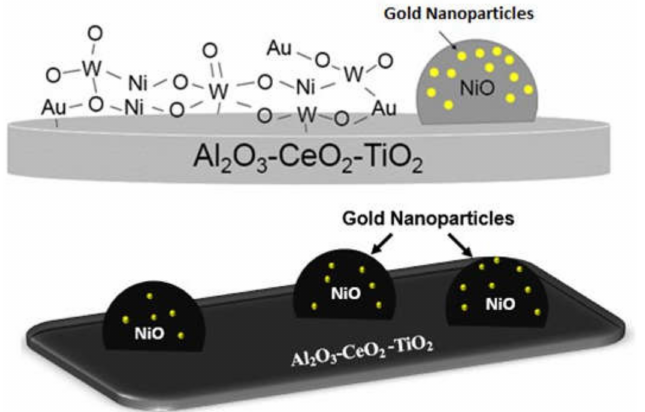
Figure 10. Nanoparticles of Ni and Au distributed on the support for NiWAu/ACT1 nanomaterial.